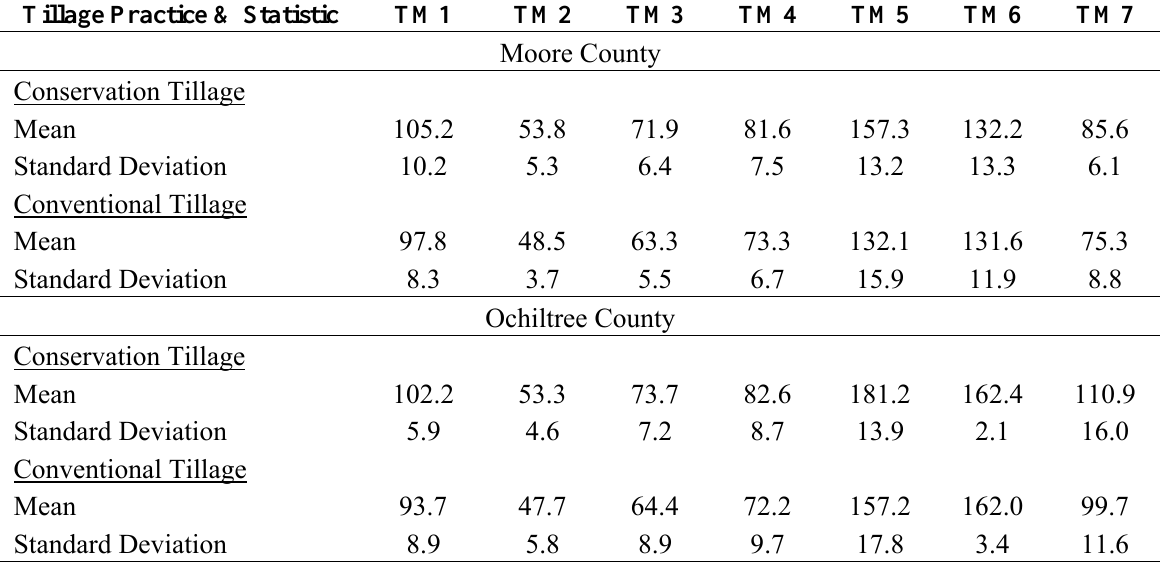
Table 2. Mean brightness values for each field in Moore and Ochiltree Counties.